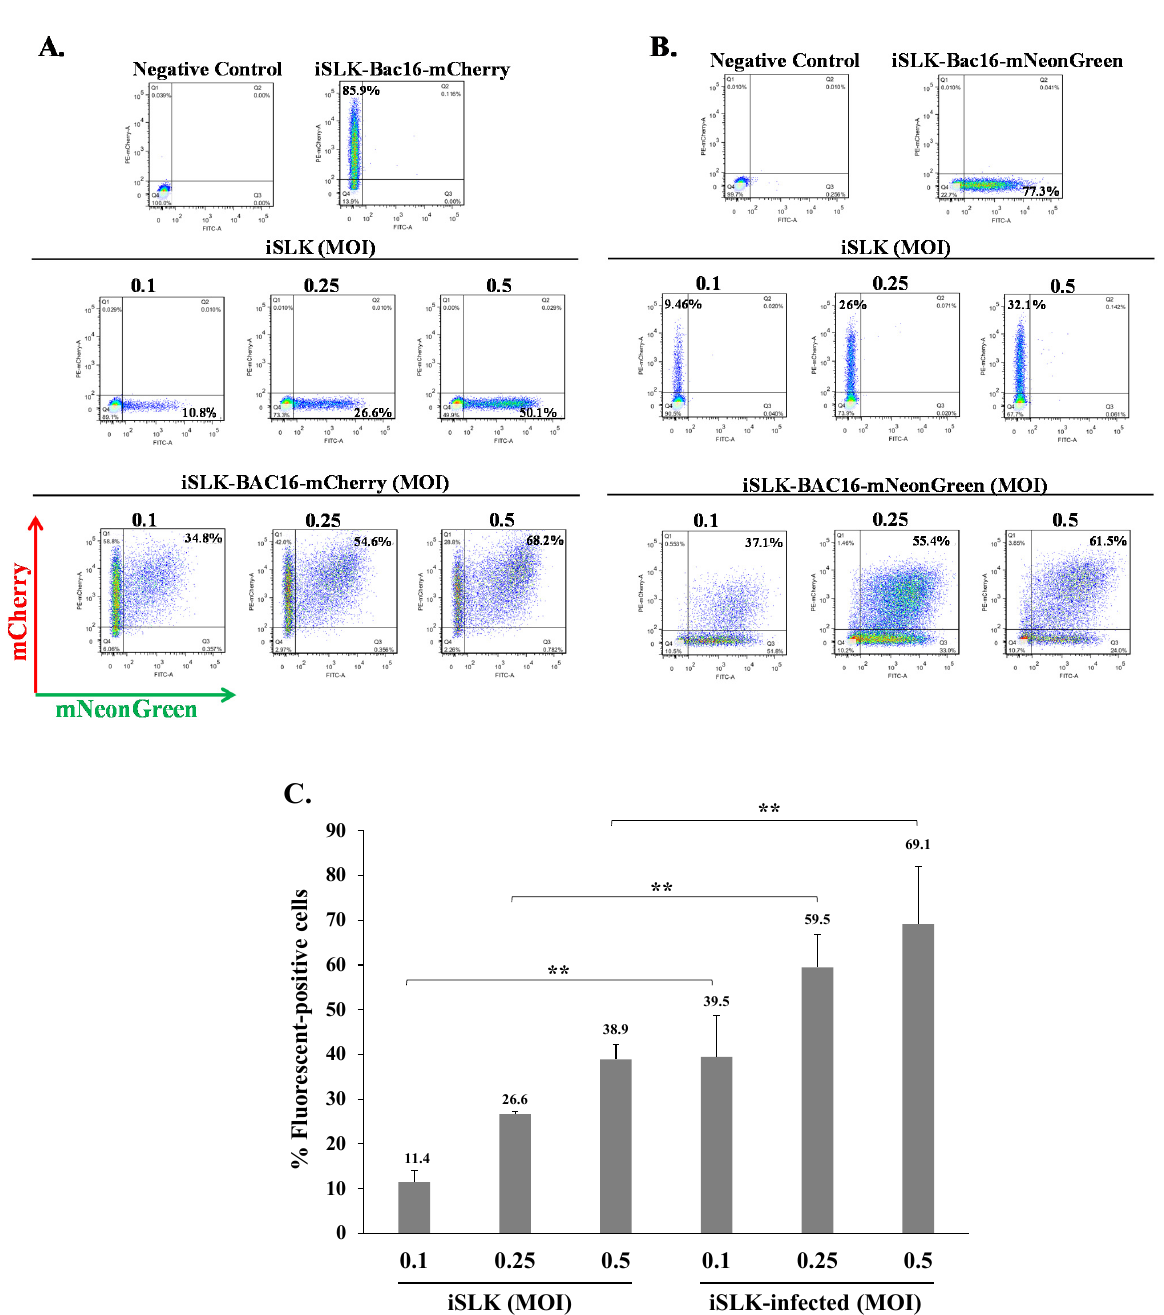
Figure 2. KSHV-infected iSLK cells can be superinfected and display enhanced expression of the fluorescent marker of the incoming virions . Naive iSLK cells and latently infected iSLK cells that carry ( A ) BAC16-mCherry or ( B ) BAC16-mNeonGreen were seeded in six-well plates (500,000 cells per well). The next day, the cells were infected with ( A ) BAC16-mNeonGreen or ( B ) BAC16-mCherry viruses at MOIs of 0.1, 0.25, and 0.5 using spinoculation. After 48 h, the cells were harvested, and the percentages of cells expressing mNeonGreen and mCherry were measured by FACS. ( C ) Percentage of cells expressing the fluorescent protein (mNeonGreen/mCherry) encoded by the incoming viral genome. iSLK—naive uninfected cells, iSLK-infected-latently iSLK-infected cells that were re-infected. Results show the average of three independent experiments. Statistical analysis was carried out using Tukey’s post hoc analysis test. ** p < 0.01. Naive uninfected iSLK cells were used as a negative control, while iSLK-BAC16-mCherry and iSLK-BAC16-mNeonGreen served as positive controls.